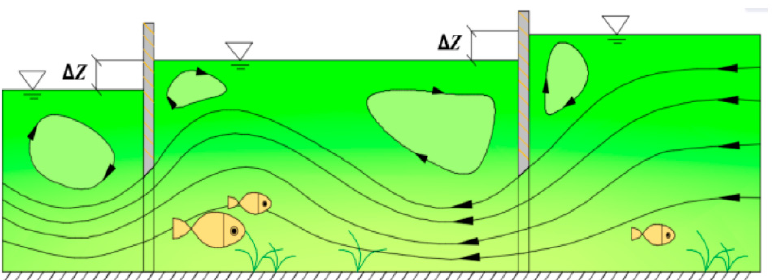
Figure 2. Sketch of multistage orifice outflow. Submerged outflow through the orifices leads to the contraction of the streamline distribution upstream and increase in the flow velocity gradually near the orifice. Discontinuous water surface and lack of eco-friendliness are the disadvantages of this structure.